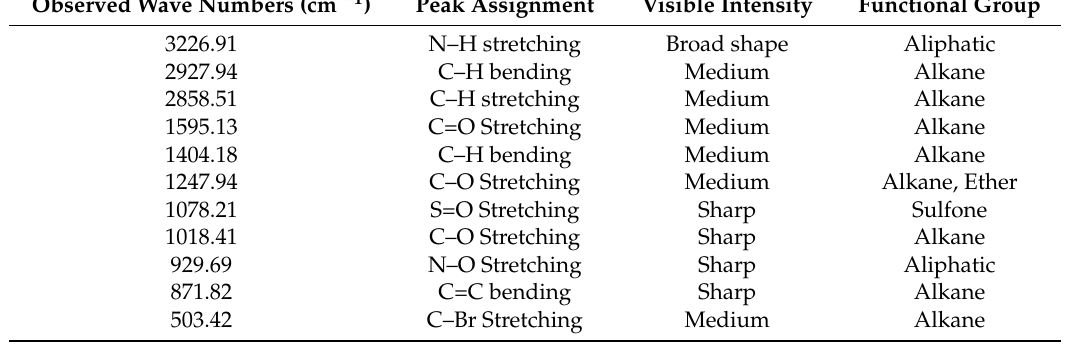
Table 4. Beauveria bassiana -28 mycelial crude metabolites of FT-IR Spectrum study.